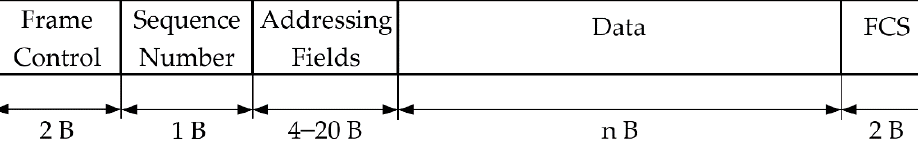
Figure 6. Data frame format.